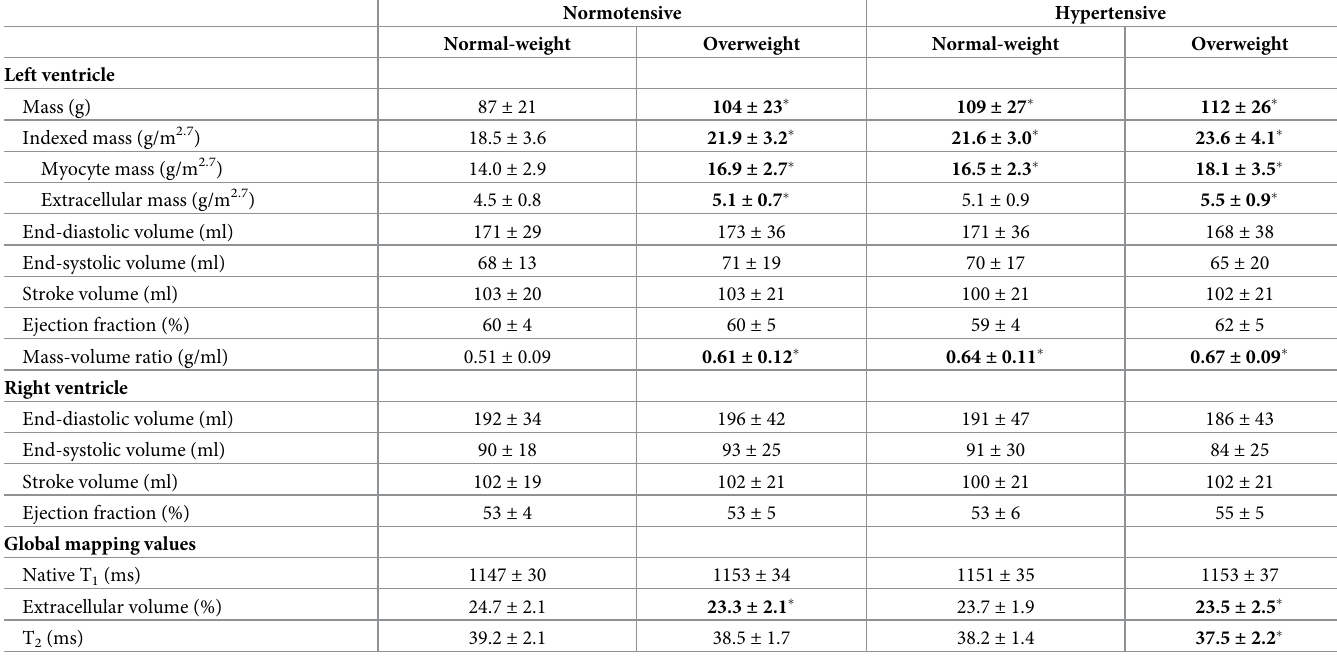
Table 2. Cardiac morphology, function and tissue characteristics per